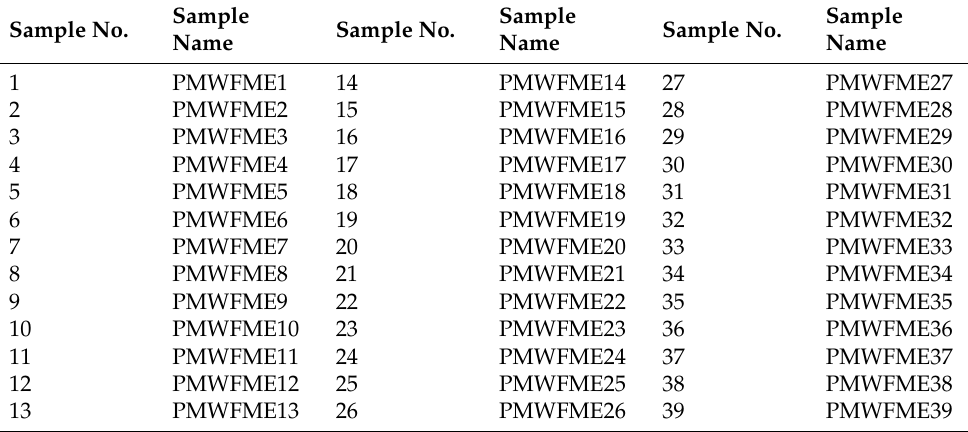
Table 8. PM-WFME samples used in this study. Sample